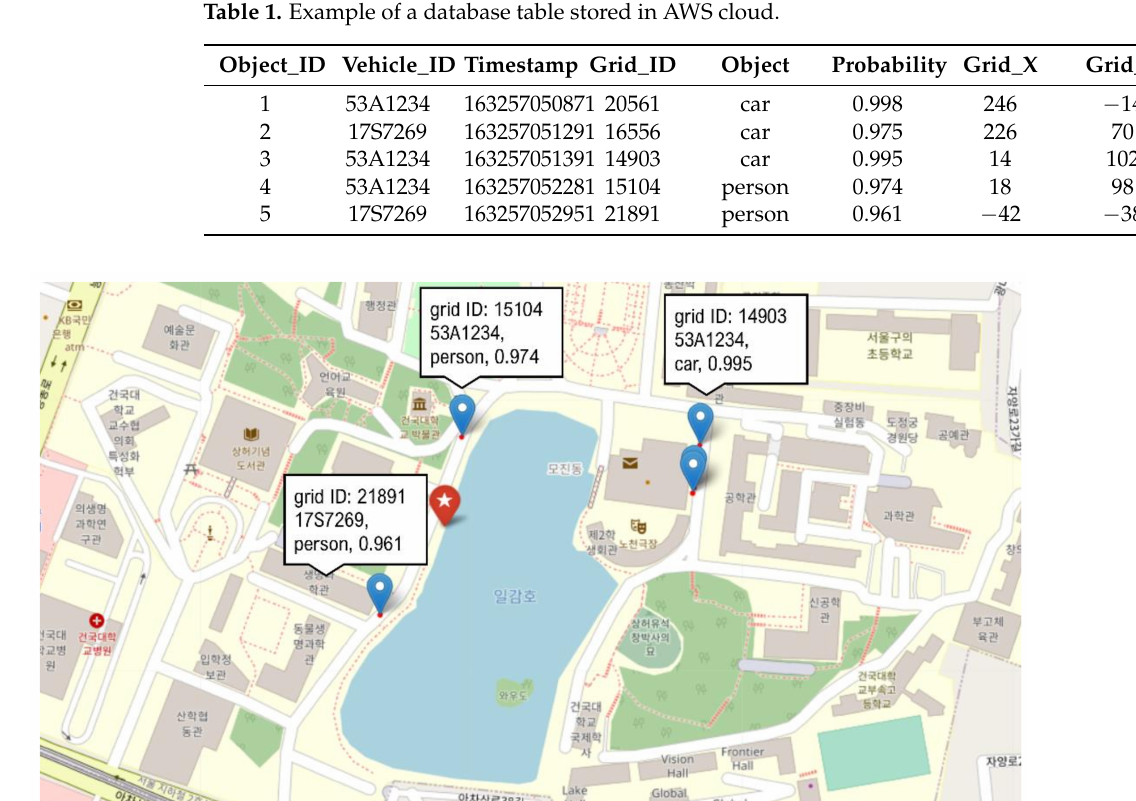
Figure 11. Dynamic map visualization on the edge device